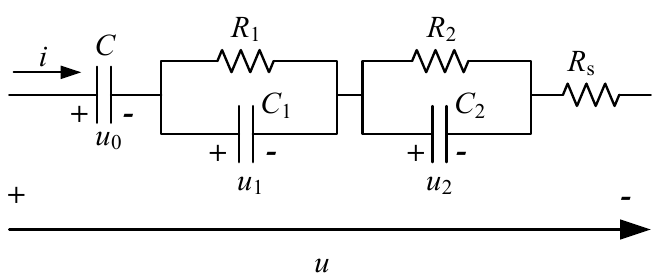
Figure 1. The ultracapacitor model